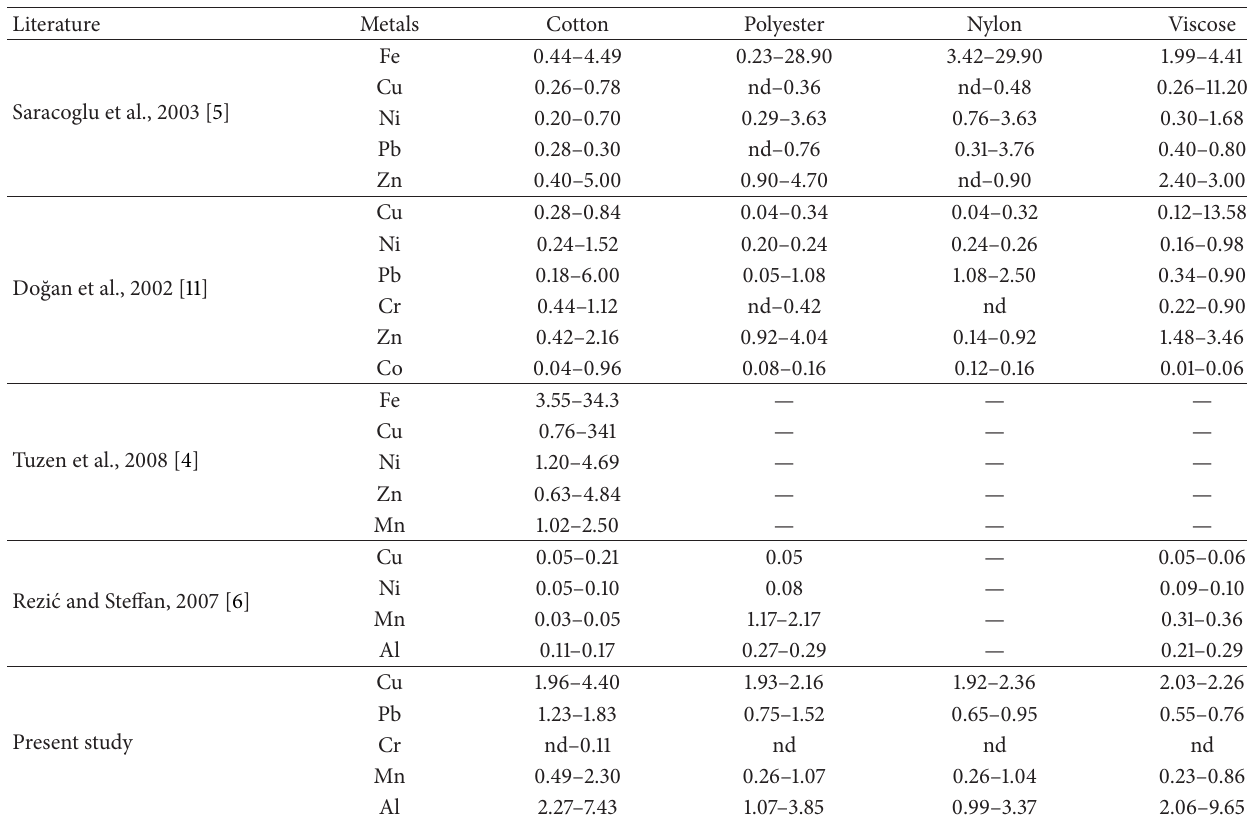
Table 5: Literature values of heavy metals (as mg kg −1 ) in textile